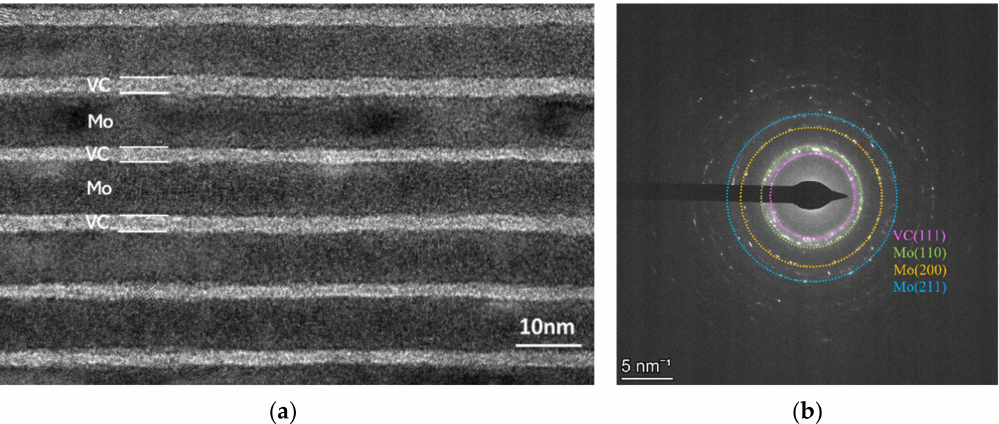
Figure 3. Cross-sectional TEM images of Mo/VC multilayers with η Mo/VC = 8:2: ( a ) Bright field image, ( b ) Corresponding diffraction